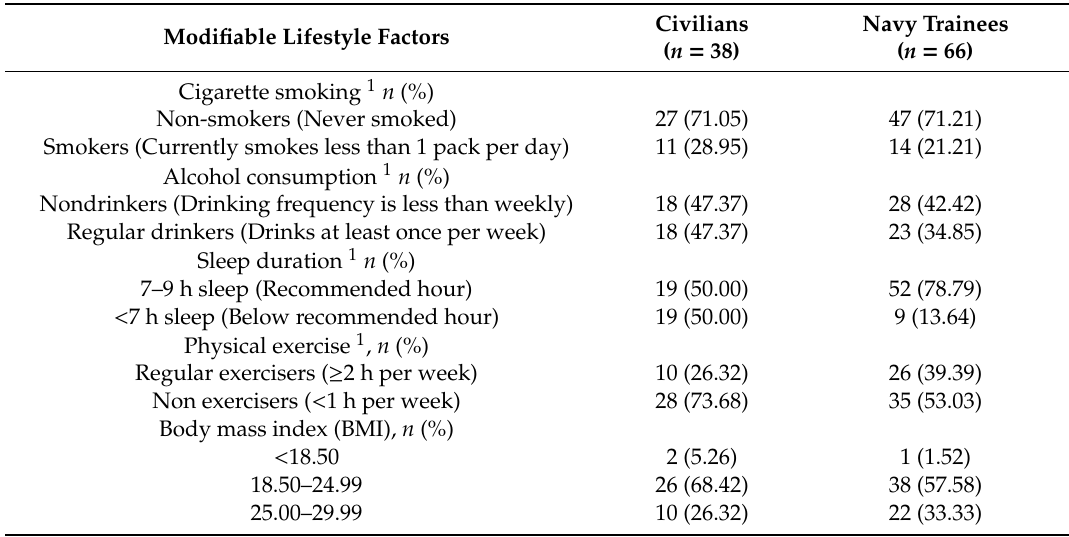
Table 1. Modifiable-lifestyle factors of civilian and navy trainee